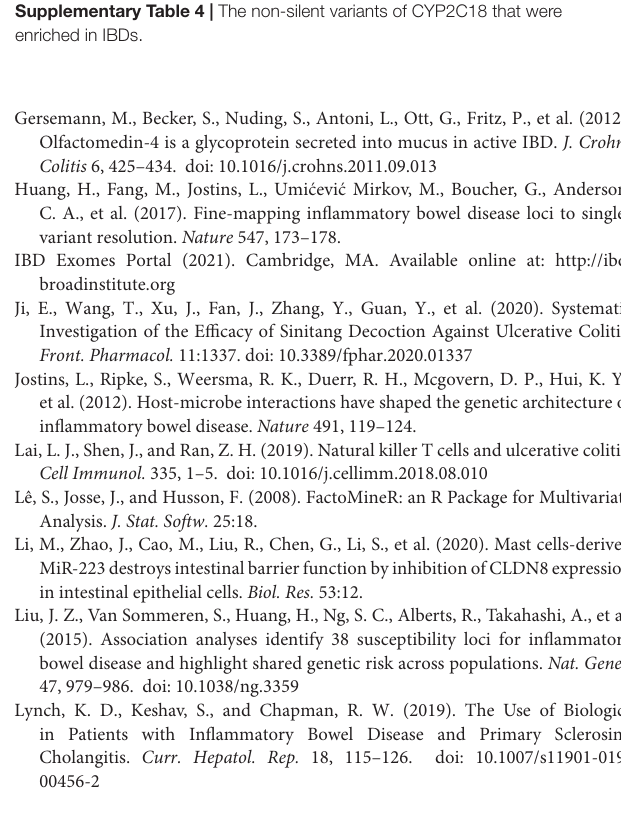
Supplementary Figure 3 | Volcano plot of the differentially expressed genes in the healthy twin pairs. All the genes show stable expression spectrum between